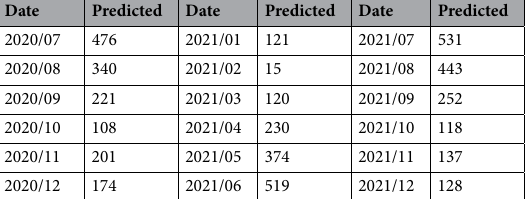
Table 4. The number of predicted human brucellosis cases in Xinjiang by the SARIMA((1,4,5,7),0,0)(0,1,2) 12